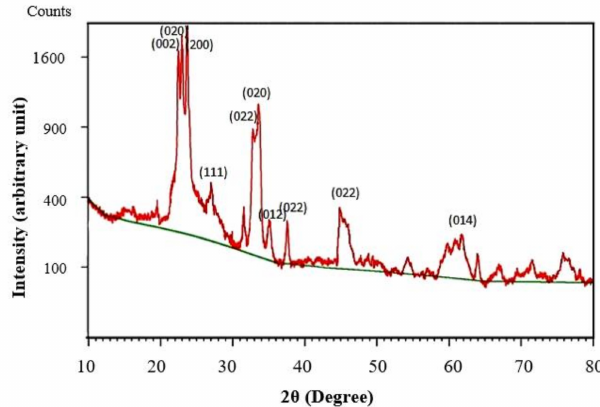
Figure 28. XRD spectrum of PANI/WO 3 /CuCl 2 after formation of copper sulfide in the composite due to interaction with H 2 S